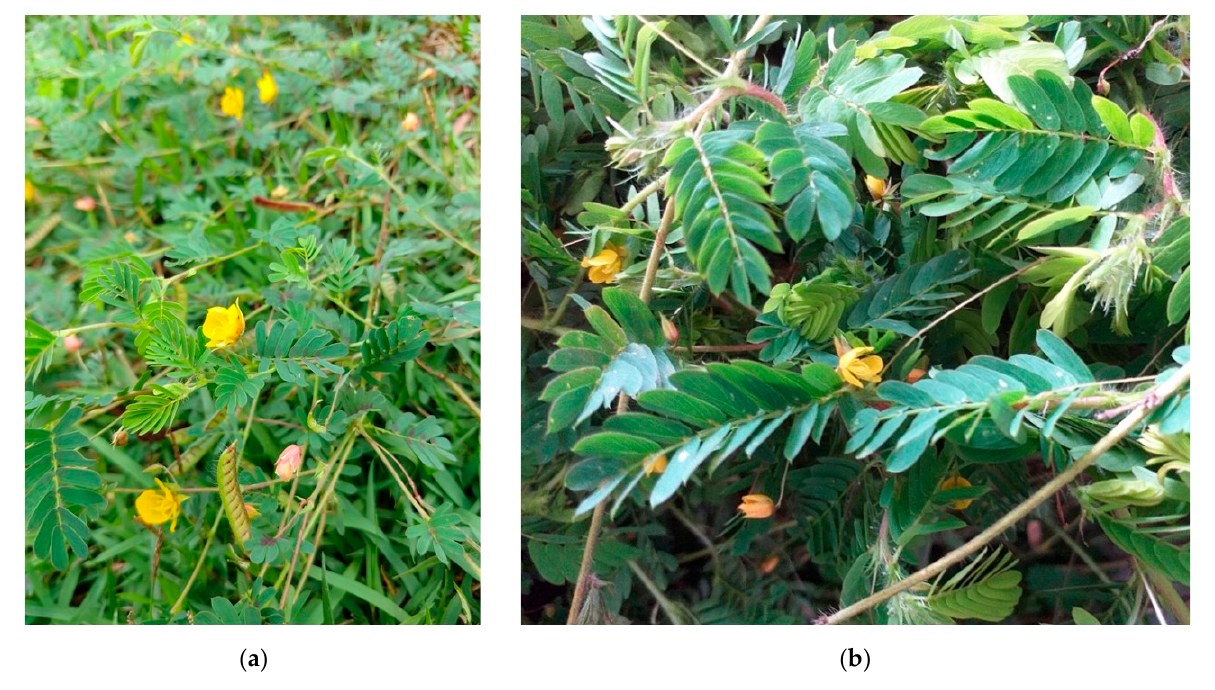
Figure 1. Experimental poisoning by Chamaecrista serpens in sheep. Samples of Chamaecrista serpens in flowering and fruiting. ( a ) C. serpens in native pasture. Santaluz, BA, property where outbreaks of natural intoxication occurred. ( b ) Fresh plant used in the experiments.